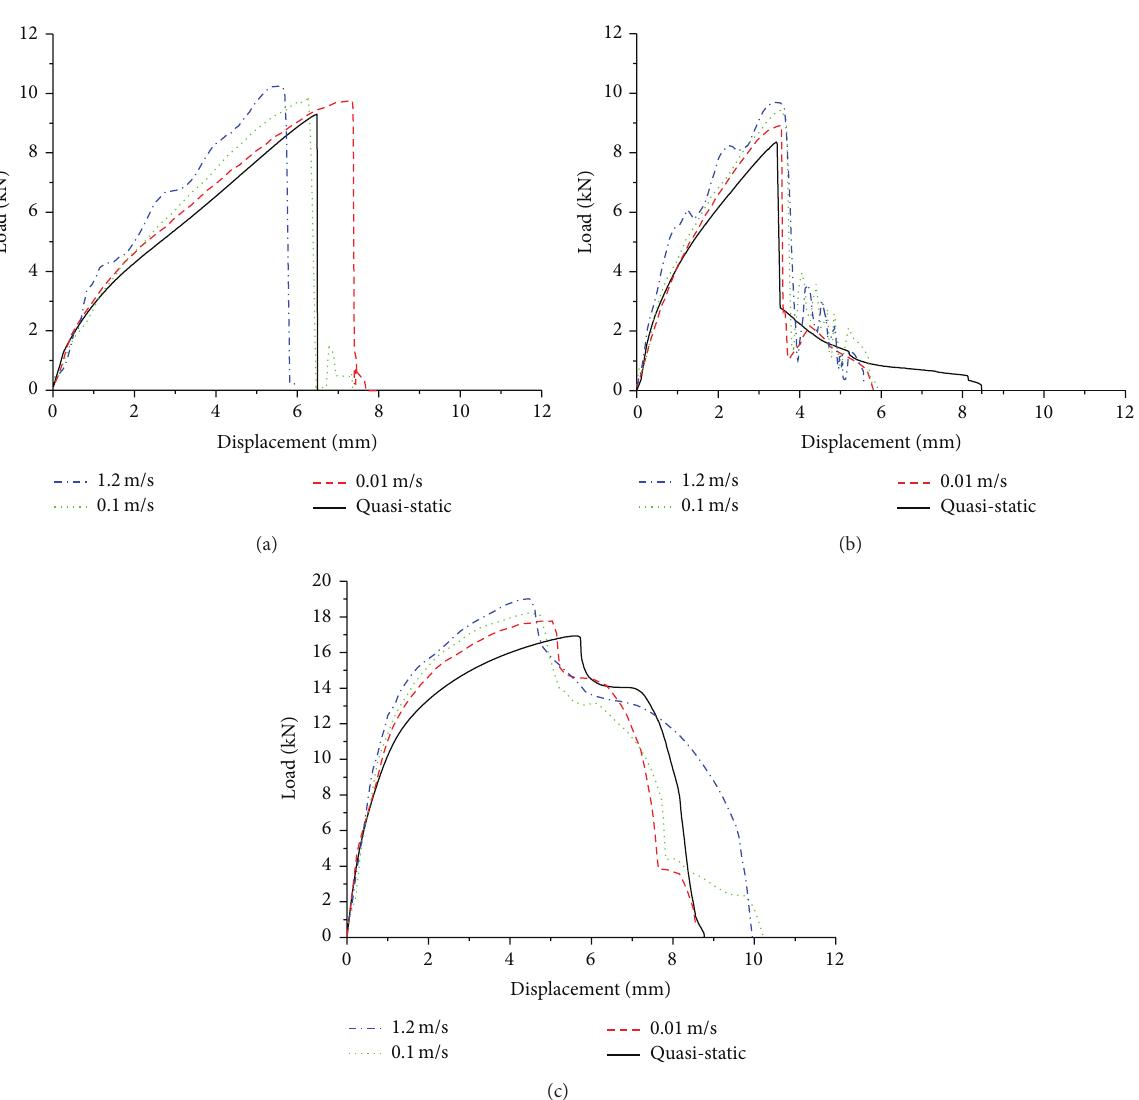
Figure 8: Load-displacement curves of spot-welded specimens for DP590 at various loading angles: (a) 0 ∘ ; (b) 45 ∘ ; (c) 90 ∘ .